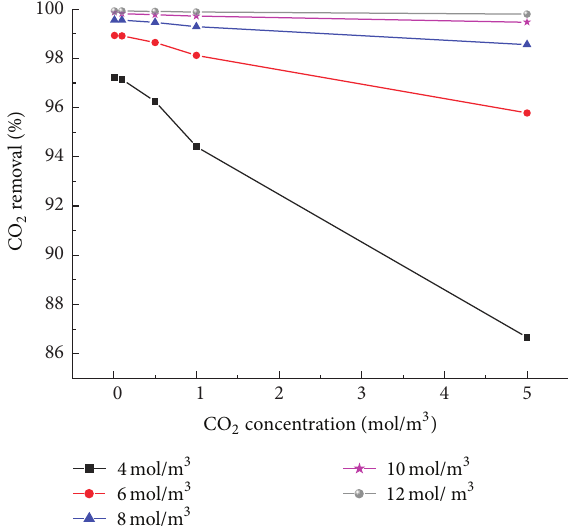
= 12 mol m −3 , V MEA ,0